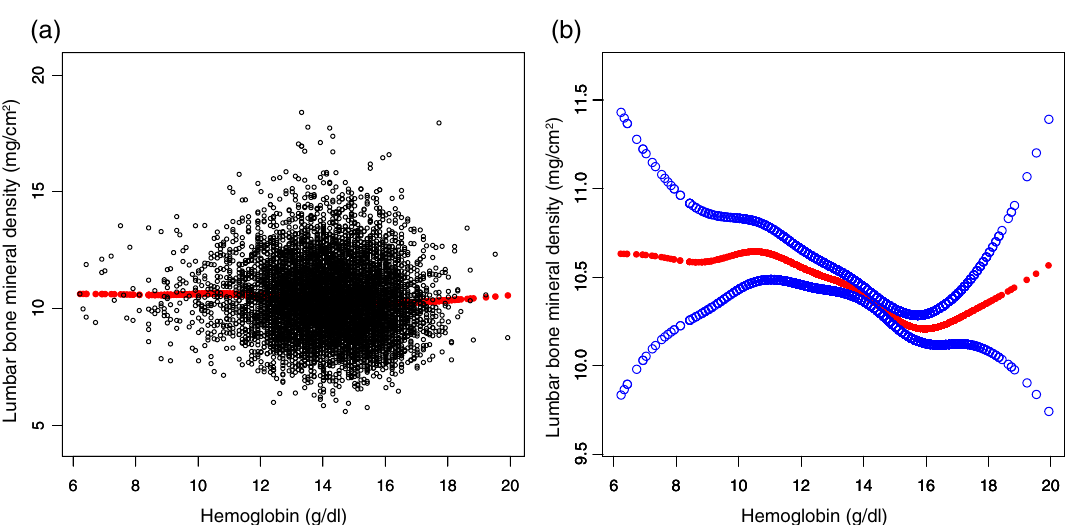
Figure 2. Correlation between hemoglobin and thoracic bone mineral density. ( a ) Each black point represents one sample. ( b ) The area between the two blue dashed lines is represented as a 95% CI. The area between the lines is expressed as 95% CI. Each point represents the size of the hemoglobin and is connected into a continuous line. Age, sex, race, annual household income, education level, SBP, DBP, BMI, red blood cell count, albumin, ALP, ALT, blood urea nitrogen, total calcium, iron, CPK, creatinine, glucose, LDH, phosphorus, total bilirubin, total protein, uric acid, albumin creatinine ratio, blood cadmium, blood lead, phosphorus, potassium, triglyceride, LDL-C, HDL-C, total cholesterol, alcohol status, smoking status and diabetes were adjusted.